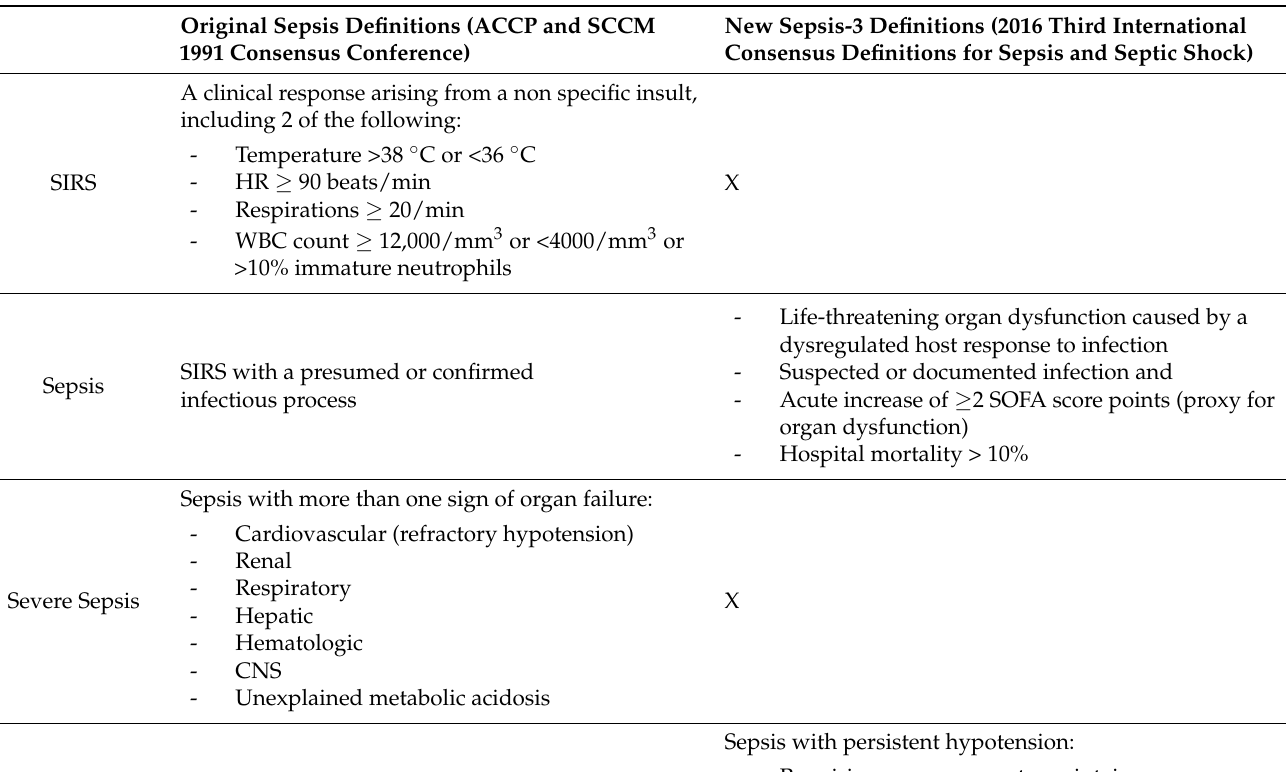
Table 1. Evolution of sepsis definition over